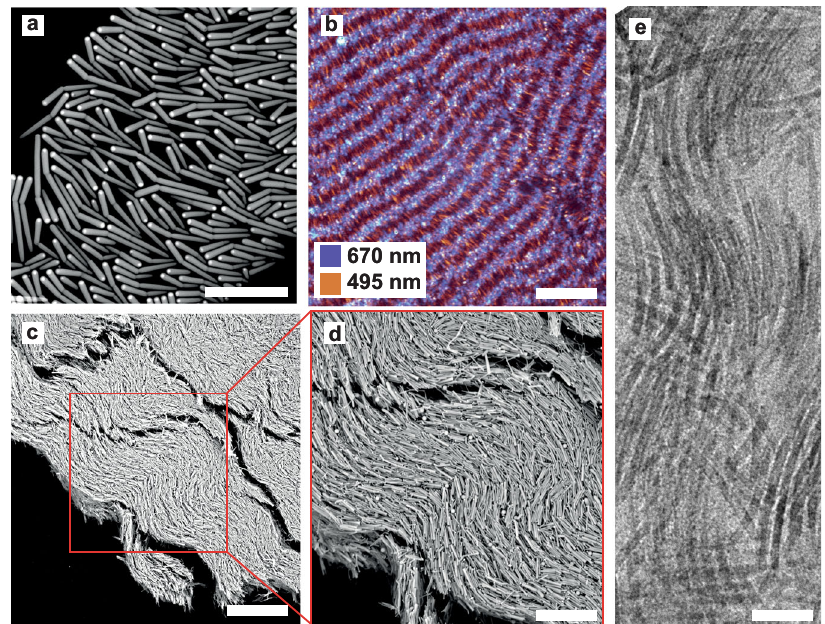
Fig.5|Phasebehaviorofhematitecore-shellBSRs(CS-BSRs).a (S)TEMimageof CS-BSRs.Thehematiteellipsoidwaslocatedatoneendoftherodwithitslongaxis perpendicular to the rod length as the CS-BSR were obtained via a seeded growth methodology. b Smectic domain as imaged by re fl ection confocal microscopy. c Dry pellet of CS-BSRs displaying an internal structure compatible with an N SB